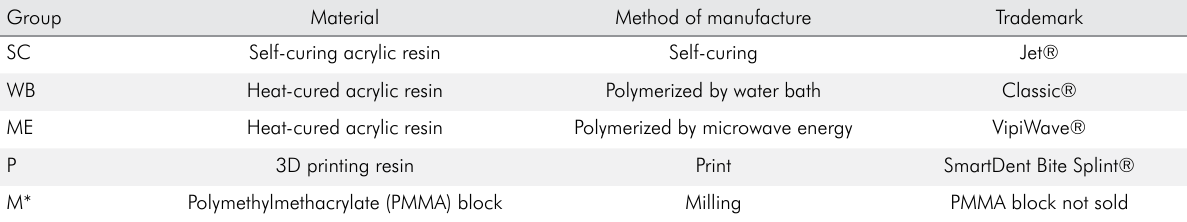
Table 1. Description of the materials used to make the study samples.